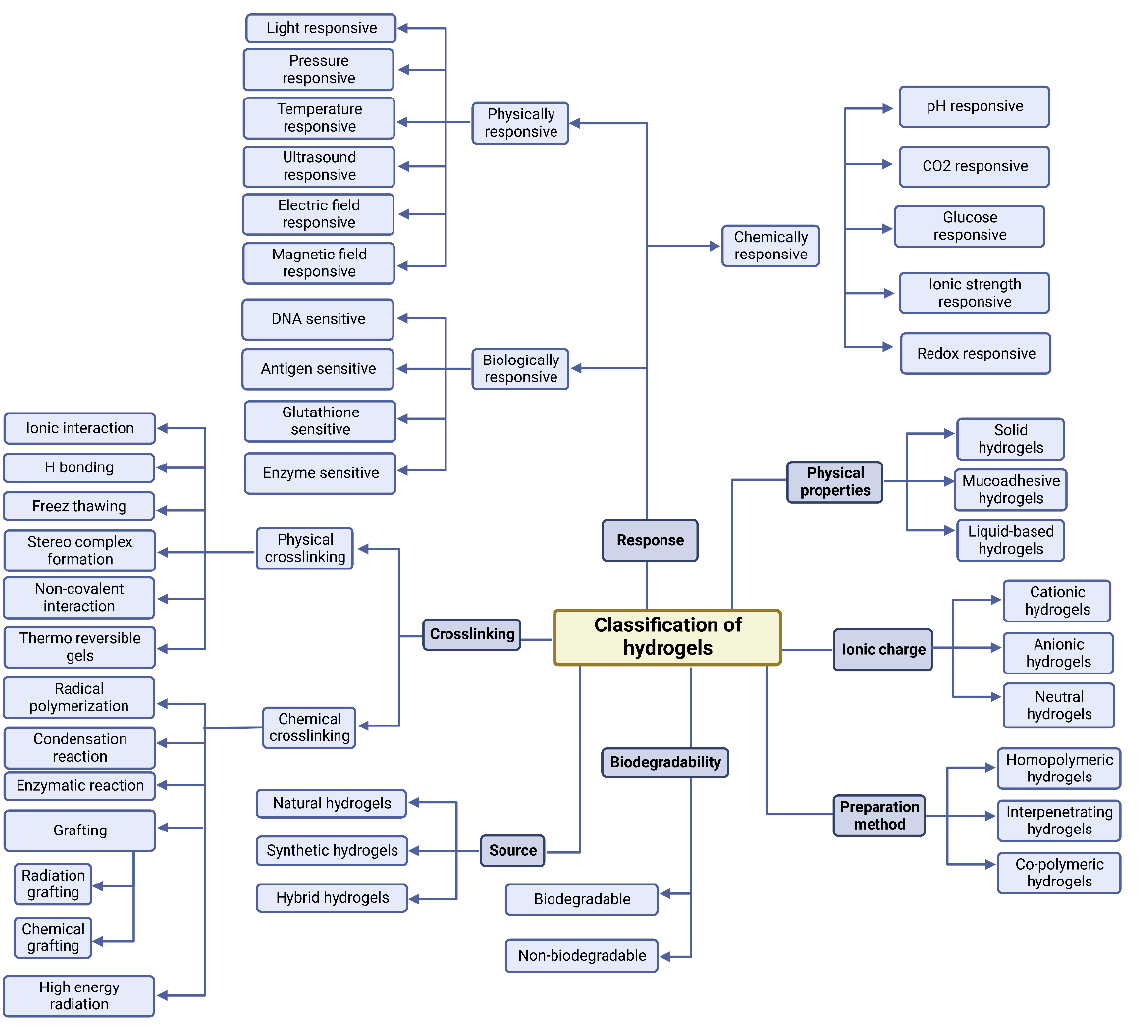
Figure 1. Classification of hydrogels according to their various characteristics.